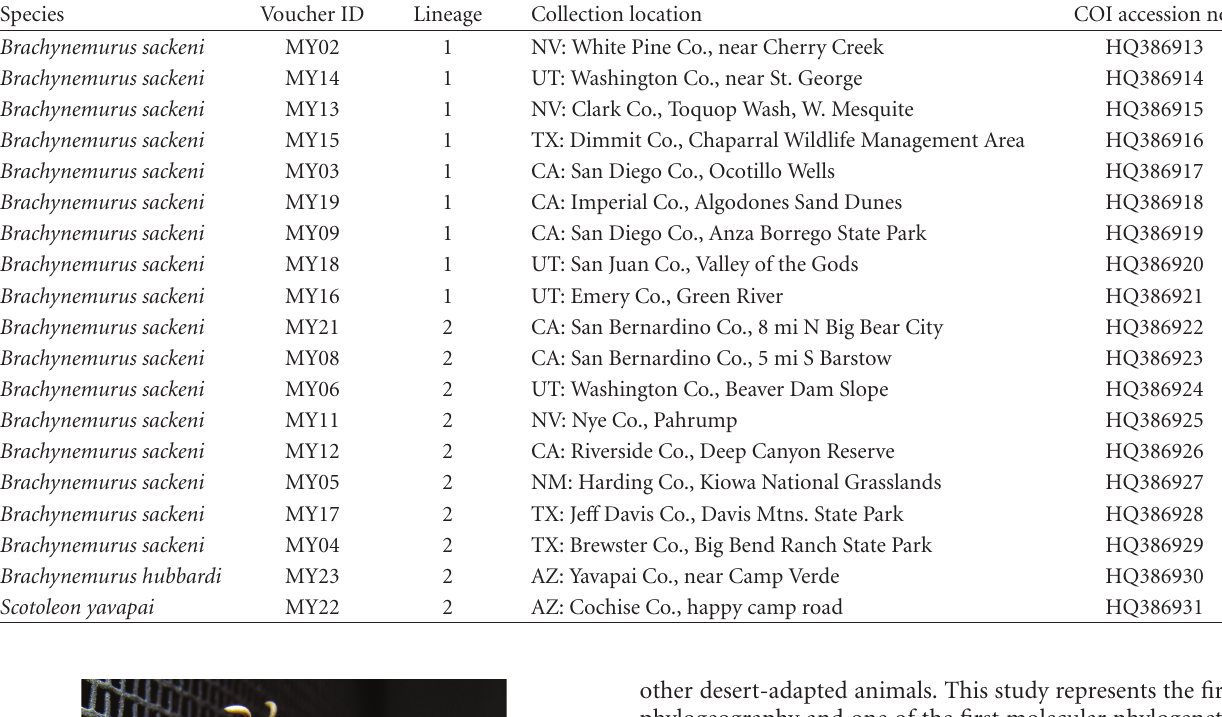
Table 1: Descriptive information for all of the taxa used in this study.